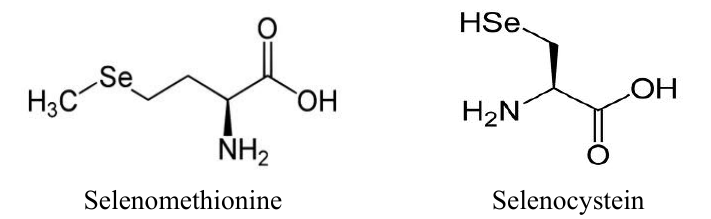
Figure 1. Selenomethionine and selenocysteine the main of organic forms of selenium.